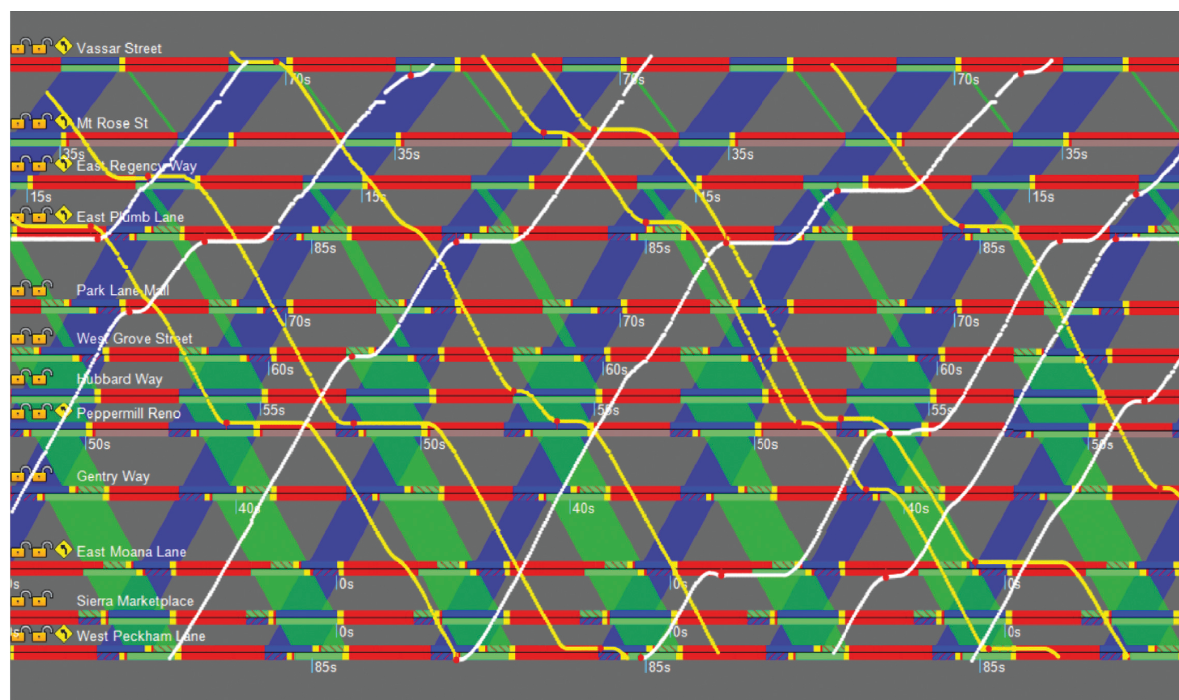
Figure 11: Vehicle trajectories under free